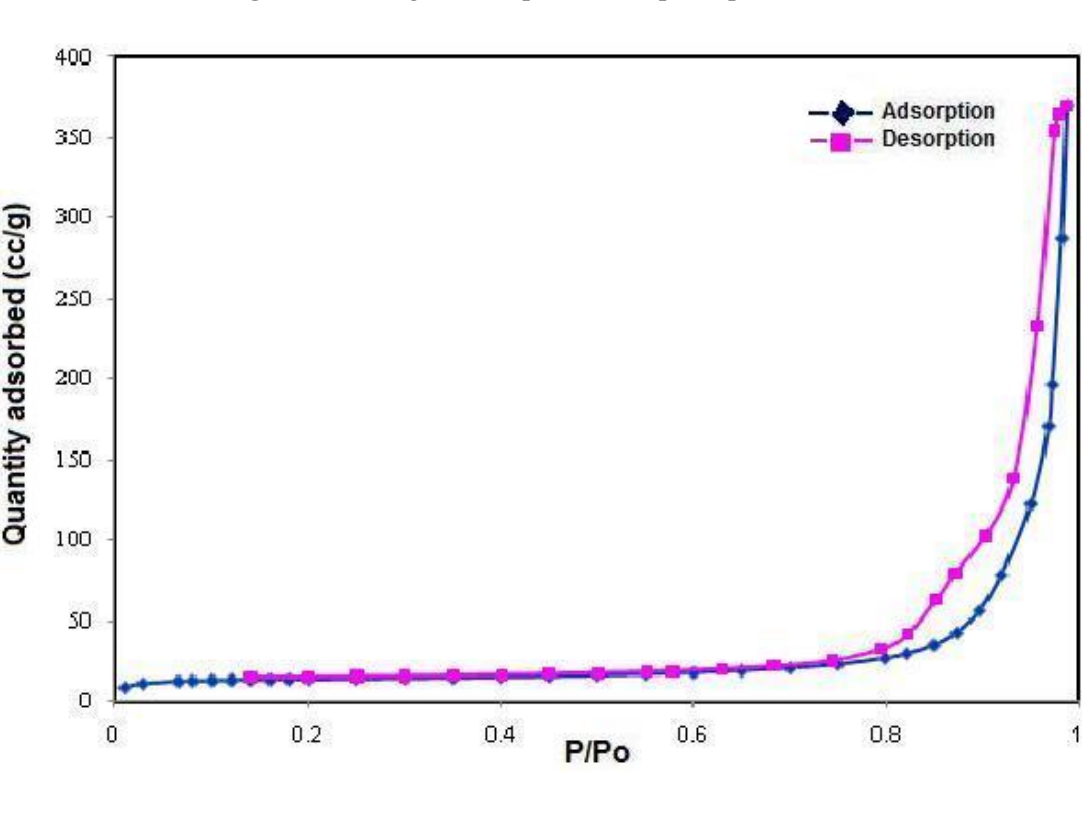
Figure 7. Nitrogen adsorption-desorption plot of